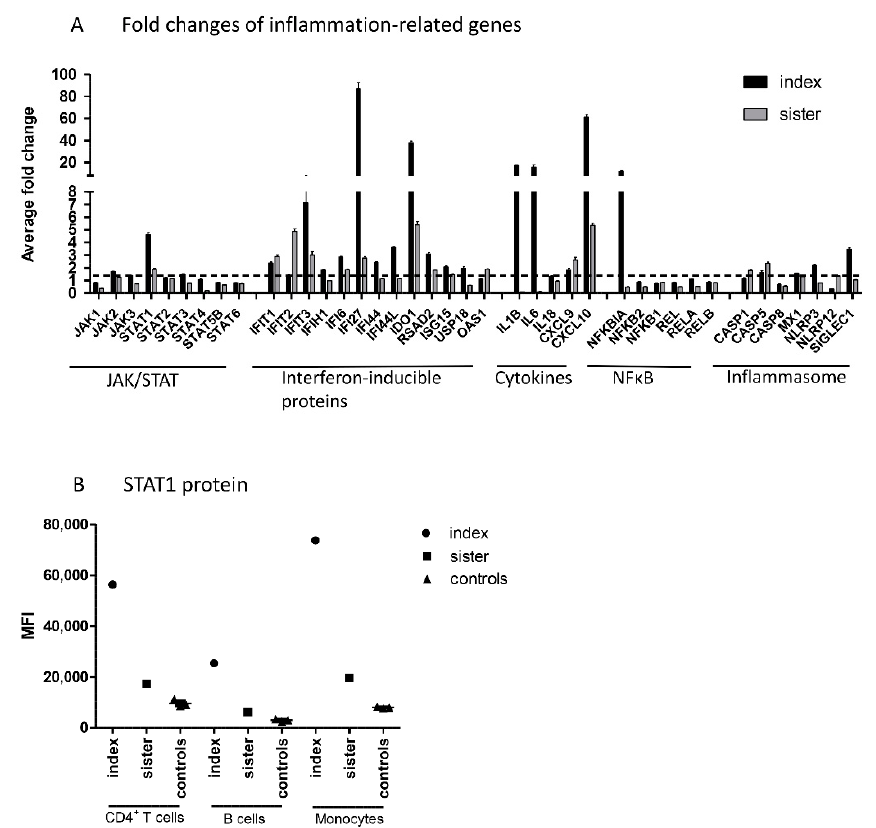
Figure 2. ( A ) Fold changes of inflammation-related genes in PBMCs from patients compared to those from control subjects. Inflammation-related custom gene set of the JAK–STAT pathway, interferon-inducible proteins, cytokines, NF κ B pathway, and inflammasome activation were measured using the NanoString technology. Average fold changes of three technical replicates are presented. Dashed line represents a fold change of 1.5 that was considered as a threshold for increased gene expression, ( B ) STAT1 protein level in CD4 + T cells, B cells, and monocytes measured in cells from patients and control subjects by flow cytometry. IFN; interferon, JAK; Janus kinase, MFI; median fluorescence intensity, NF κ B; nuclear factor kappa-light-chain-enhancer of activated B cells, STAT; signal transducer and activator of transcription, PBMC; peripheral blood mononuclear cell.